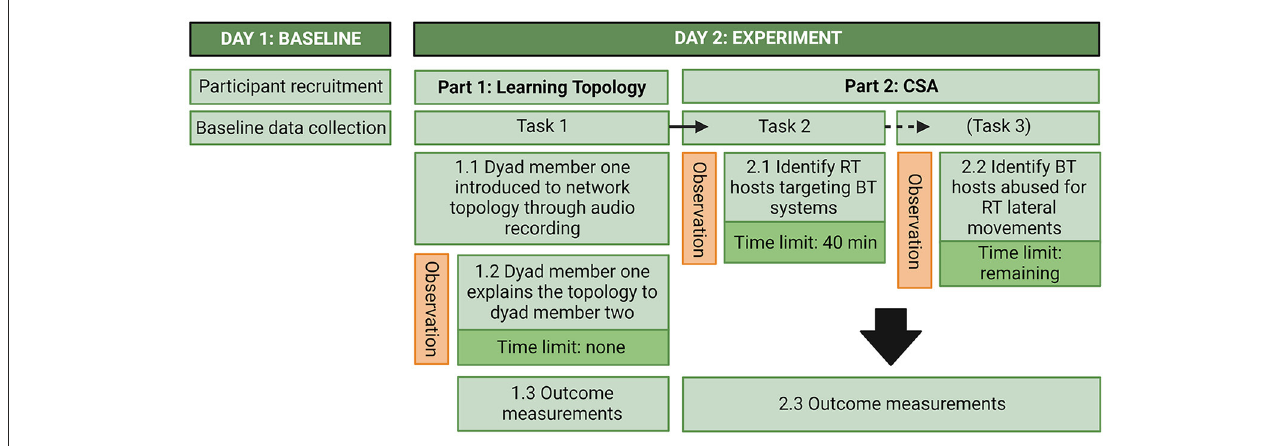
FIGURE4 Overview of the experiment. RT, Red Team; BT, Blue Team; CSA, Cyber Situational Awareness; VDE, Virtual Data